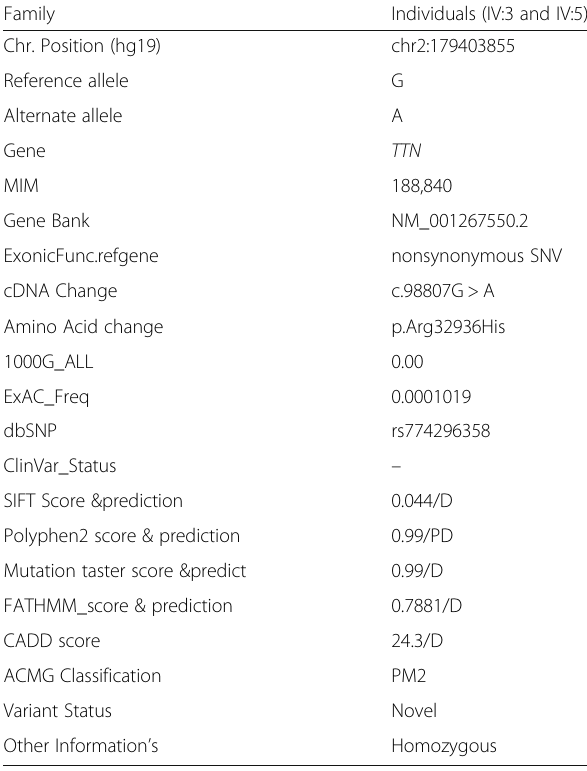
Table 2 Homozygous variant on chromosome 2 from exome data of TTN